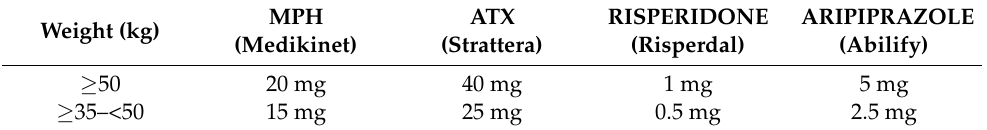
Table 5. IMP dosages for specific weight